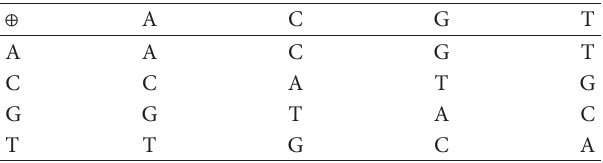
Step 1. SUM and 𝑥 sum are calculated. SUM is the sum of